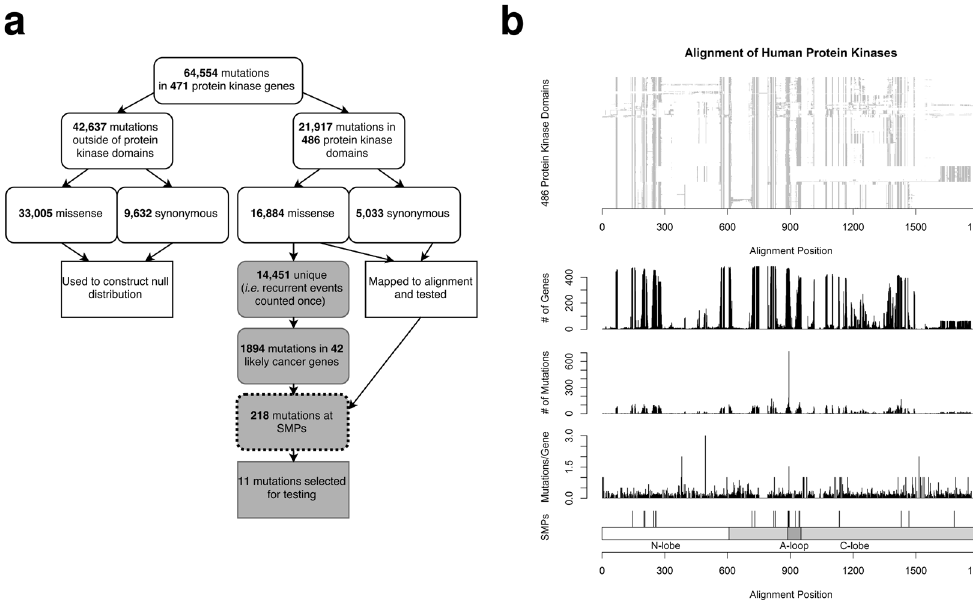
Figure 1. Study and data overview. ( a ) The use of mutations in the study. The process of choosing mutations for experimentation is in grey; the use of Significantly Mutated Positions (SMPs) is outlined. ( b ) Mapping of mutations to the protein kinase alignment. The location of 23 identified SMPs is indicated at the bottom, as well as the major regions of the aligned